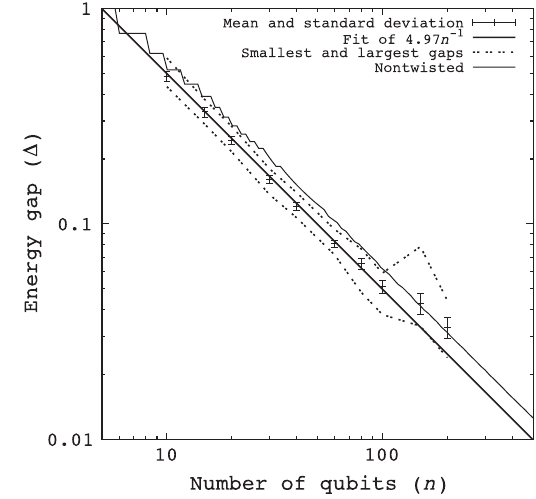
FIG. 5. Energy gap versus number of qubits for a one- dimensional twisted Hamiltonian with random angles. The dual- ity condition has been enforced so that the minimum is at s ¼ 1 (see text.) We took 200 samples with uniformly distributed random angles. We also plot the smallest and largest energy gaps that were obtained for a given number of qubits (dotted lines), as well as the case with no rotated angles (which we showed could be computed exactly) (nonbold line.) The data are well fit by ð 4 : 97 (cid:5) 0 : 02 Þ n (cid:1) 1